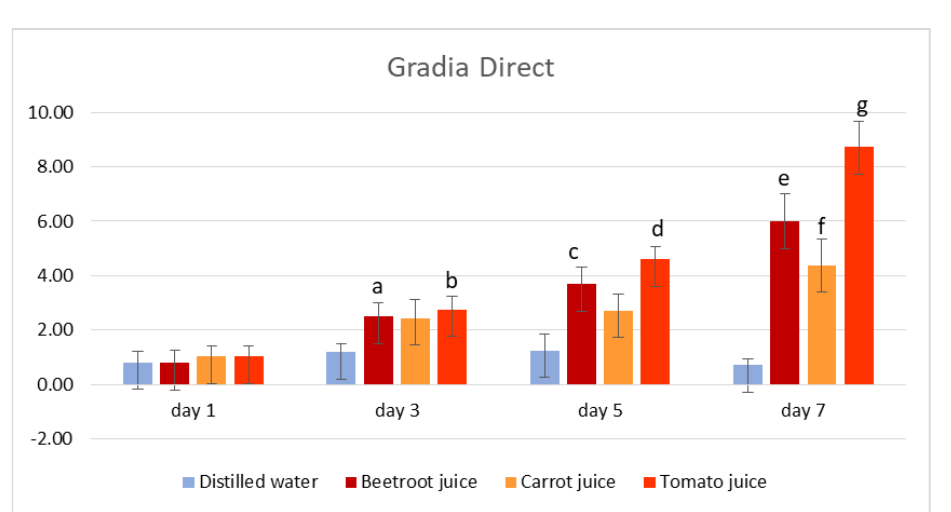
Figure 1. Colour change (mean values ± standard error of mean) for Gradia Direct samples. A lowercase letter indicates a statistical difference between the mean discolouration of samples immersed in distilled water and that of samples immersed in vegetable juice at each time point (e.g., “a” indicates a statistical difference between the mean discolouration of samples immersed in distilled water and that of samples immersed in beetroot juice for 3 days).